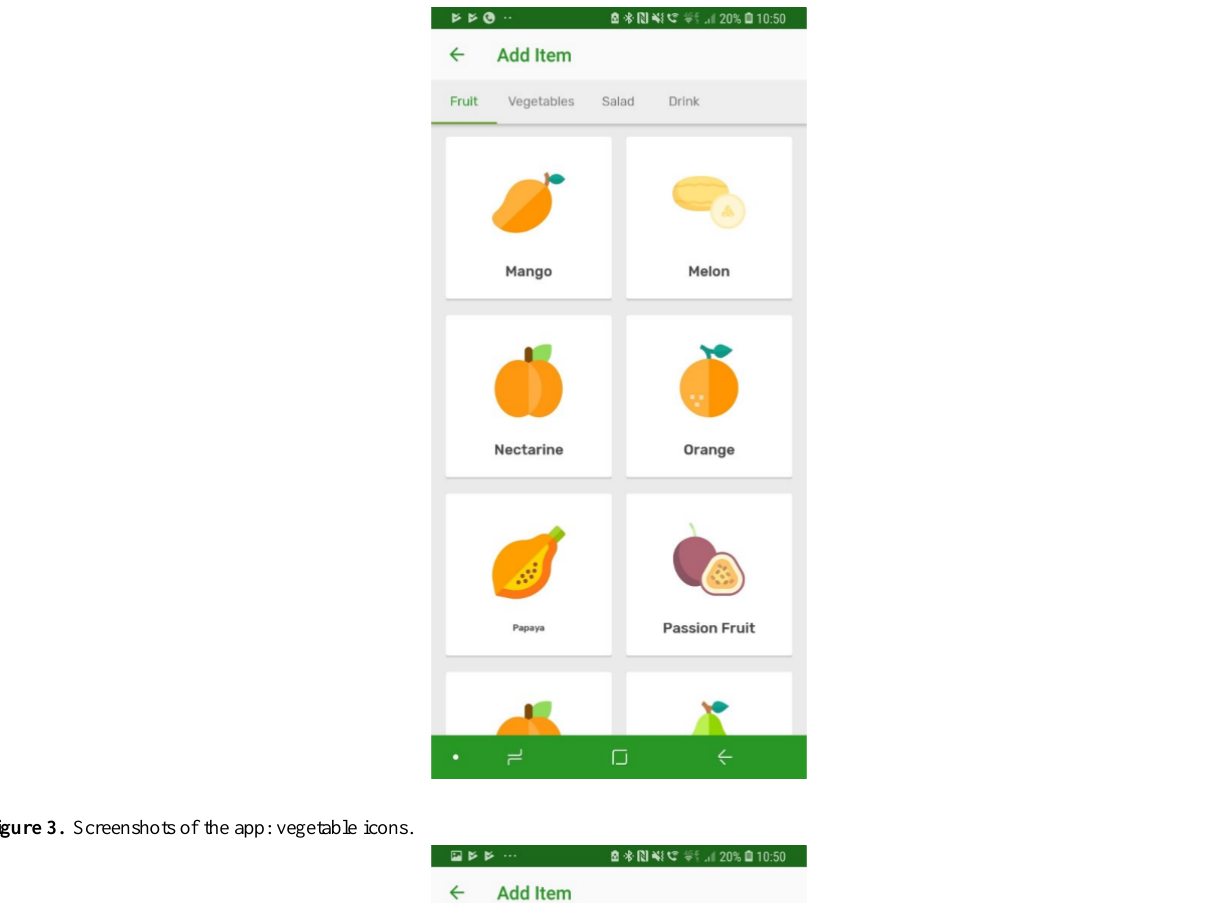
Figure 2. Screenshots of the app: fruit icons.